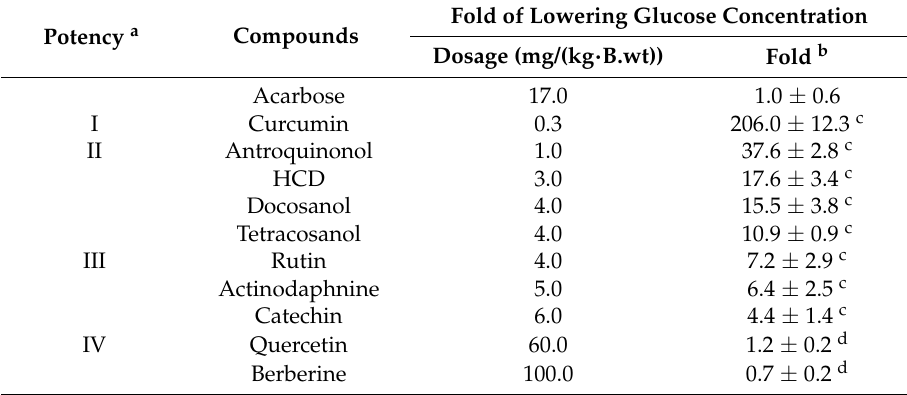
Figure 3. Hypoglycemic effects on oral administration of glucose or starch with acarbose or natural compounds in mice. 4.0 g/(kg · B.wt.) of glucose (OGTT) or 2.5 g/(kg · B.wt) of starch (OSTT) mixed with single dose of natural compounds (acarbose (Aca) 17 mg/kg, curcumin (Cur) 0.3 mg/kg, 16-hydroxycleroda-3,13-dien-16,15-olide (HCD) 3 mg/kg, docosanol (Doc) 4 mg/kg, tetracosanol (Tet) 4 mg/kg, antroquinonol (Ant) 1 mg/kg, berberine (Ber) 100 mg/kg, catechin (Cat) 6 mg/kg, quercetin (Que) 60 mg/kg, actinodaphnine (Act) 5 mg/kg, and rutin (Rut) 4 mg/kg) were oral gavaging followed by blood sampling every 30-min interval until 120 min, respectively. ( A ) Increasing blood sugar as compared with initial; ( B ) The ratio to starch; and ( C ) The ratio to glucose was calculated and compared. * p < 0.05 when compared with acarbose during glucose or starch given. Table 1. The efficacy (fold change) of natural compounds on lowering glucose concentrations in mice when compared with acarbose.